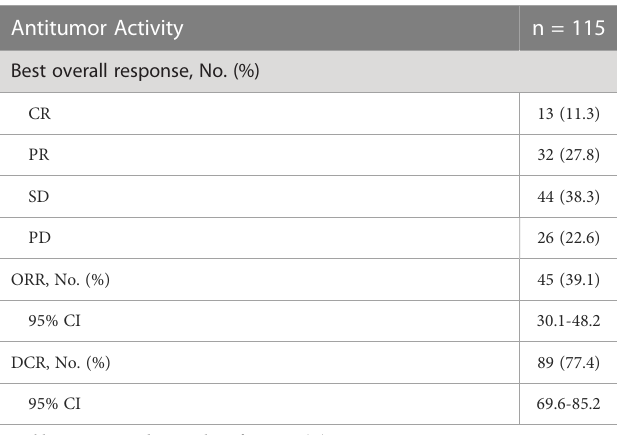
TABLE 2 Antitumor activity assessed by RECIST Version 1.1.